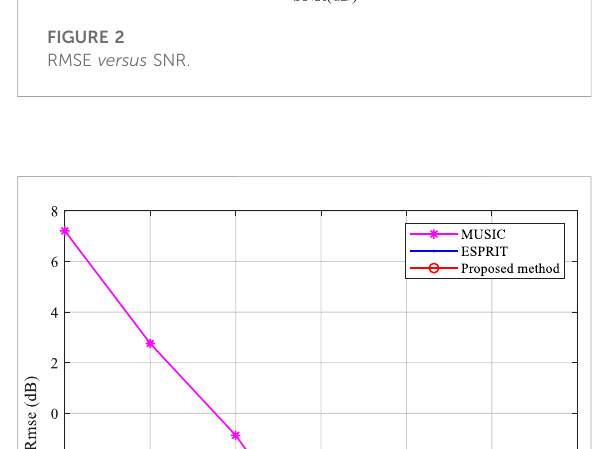
FIGURE 2 RMSE versus SNR.